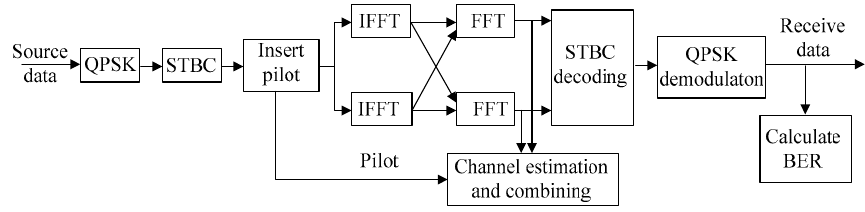
Figure 3. System simulation platform.